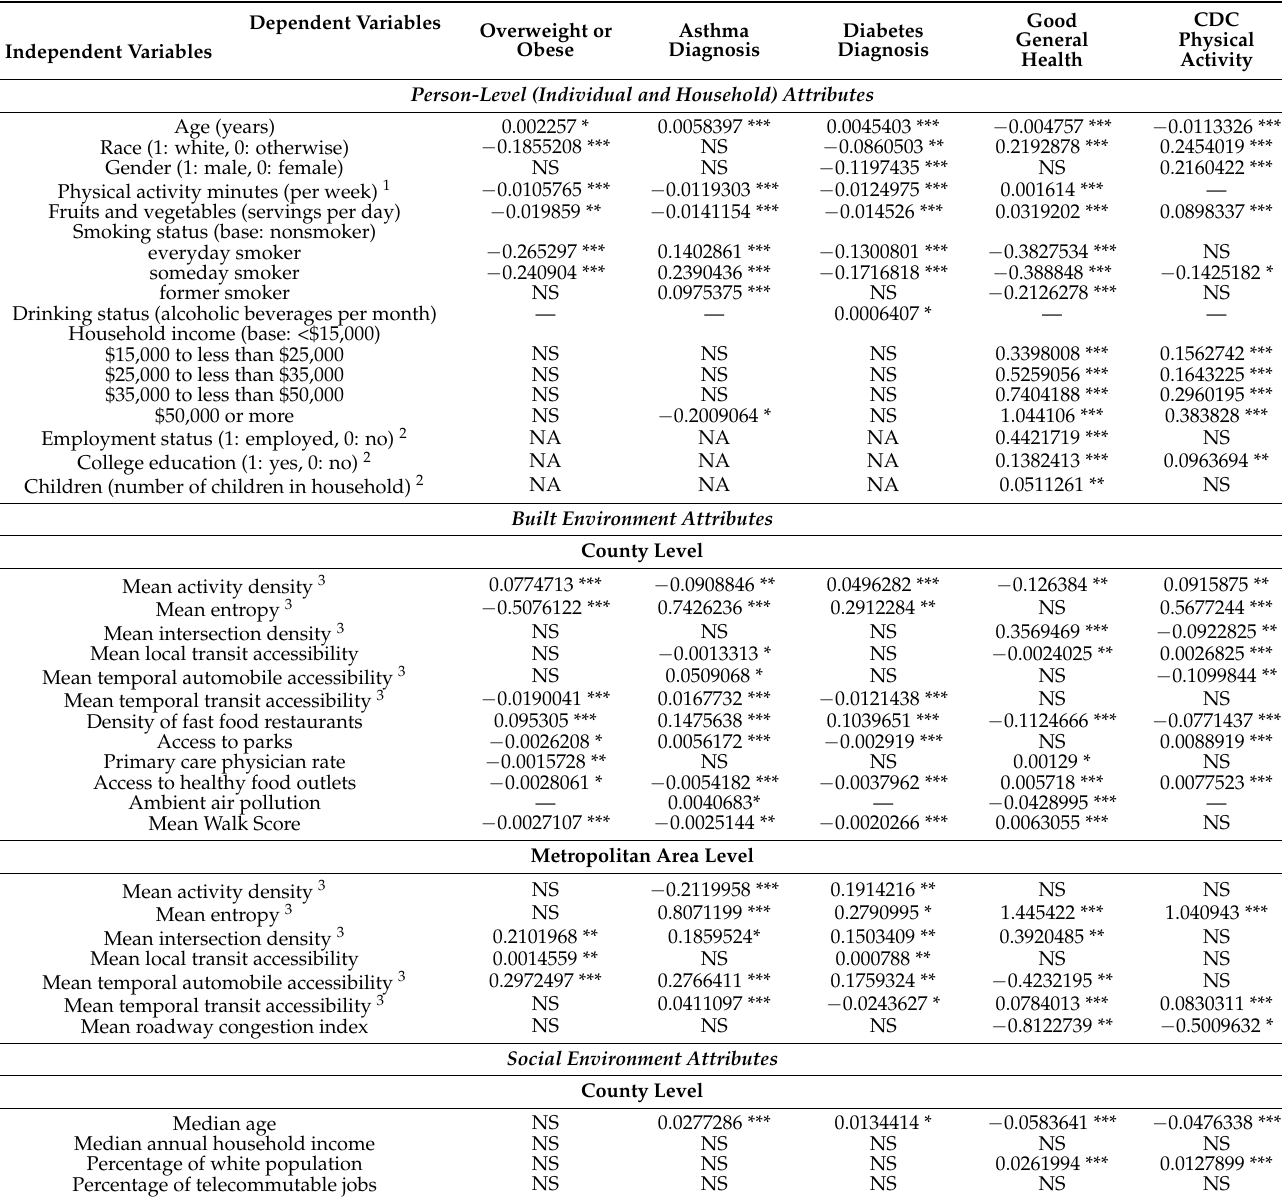
Table 2. Person-level health outcome models’ estimation